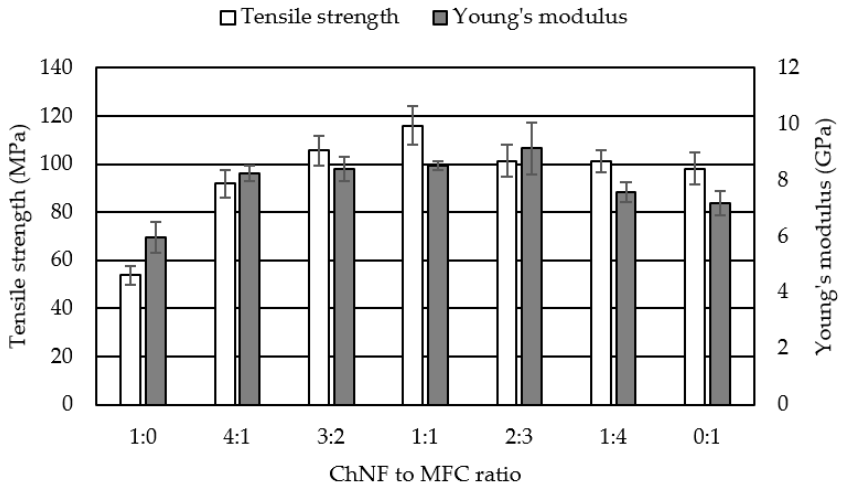
Figure 1. Tensile strength and Young’s modulus of nanocomposites with 50 wt % reinforcing phase with varying chitin nanofiber (ChNF) to microfibrillated cellulose (MFC) ratios.